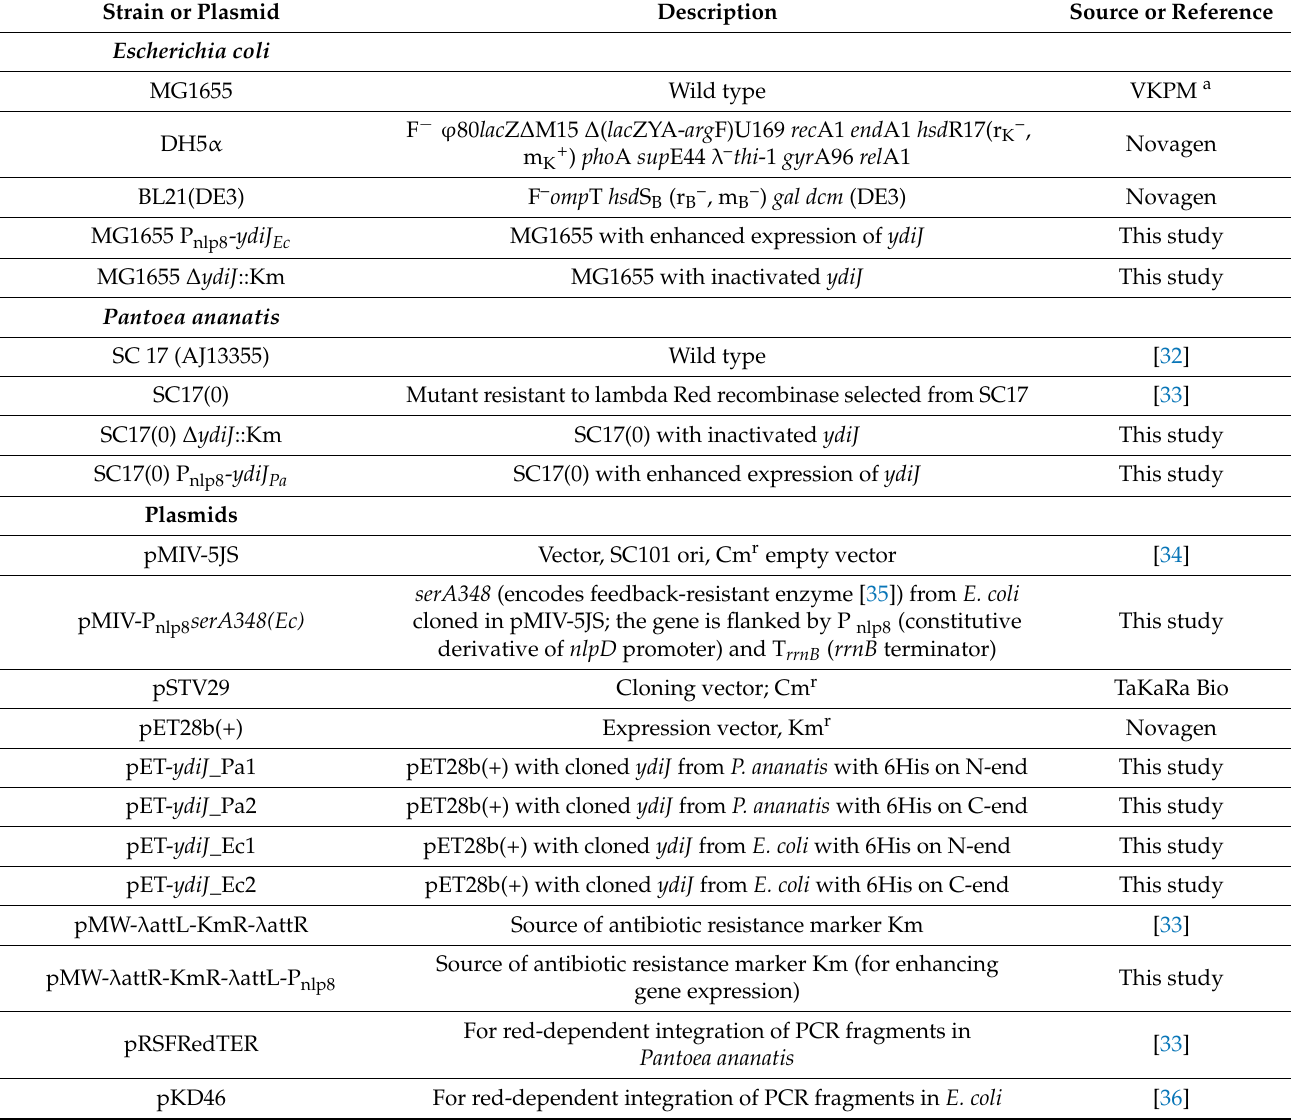
Table 1. Bacterial strains and plasmids used in this